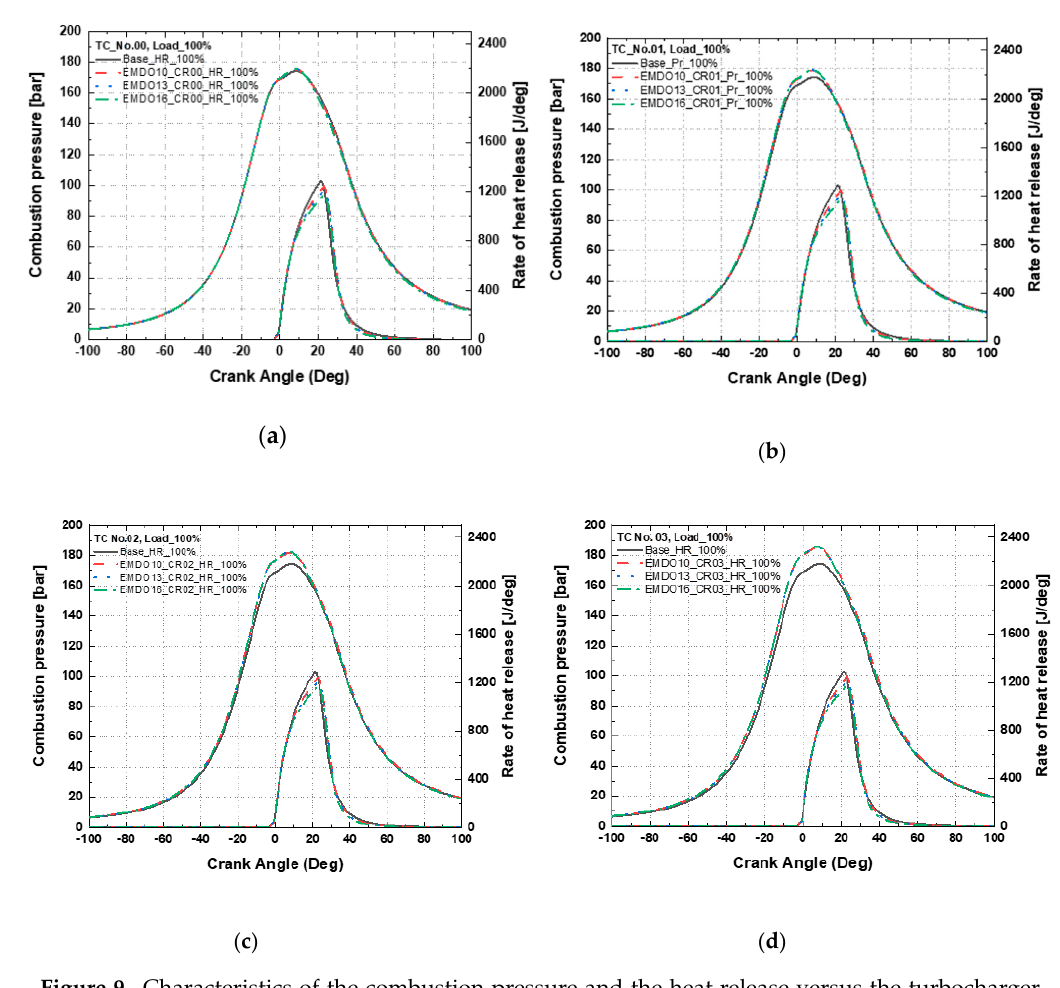
Figure 9. Characteristics of the combustion pressure and the heat release versus the turbocharger nozzle ring compression ratio. ( a ) TC No. 00. ( b ) TC No. 01. ( c ) TC No. 02. ( d ) TC No. 03.